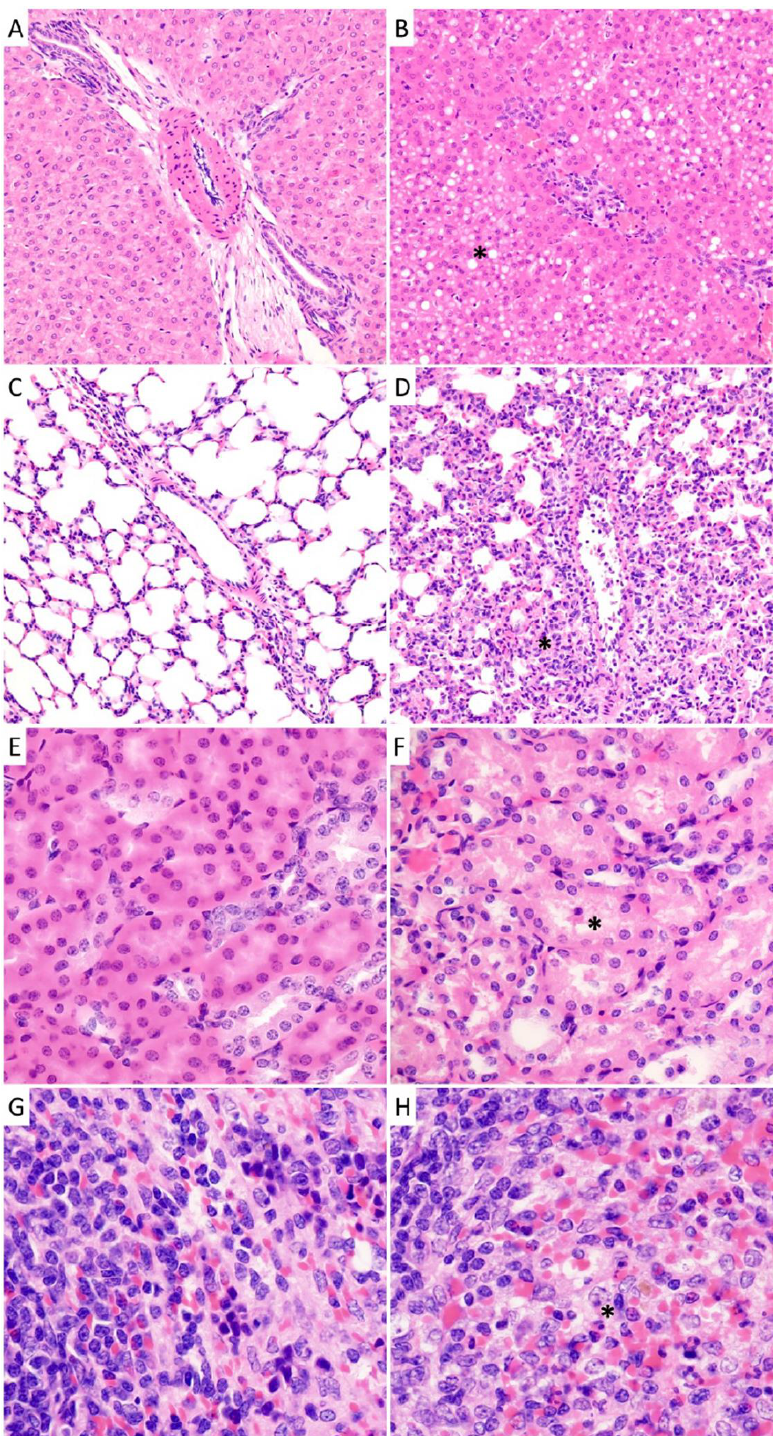
Figure 8. Histopathological analysis of tissues collected guinea pigs infected with NML-61/GPA. Guinea pigs were inoculated with 100LD 50 of NML-61/GPA and euthanized at regular intervals for histological analysis of solid organs. Shown are representative liver ( A , B ), lung ( C , D ), kidney ( E , F ), and spleen ( G , H ) specimens collected early (day 1, ( A , C , E , G )) post-infection as well as when animals were moribund (day 12, ( B , D , F , H )). Primary observations included significant and diffuse steatosis in liver sections ( B ) as well as any compromised and damaged alveoli with intra-alveolar fluid in lung sections ( D ) collected from moribund